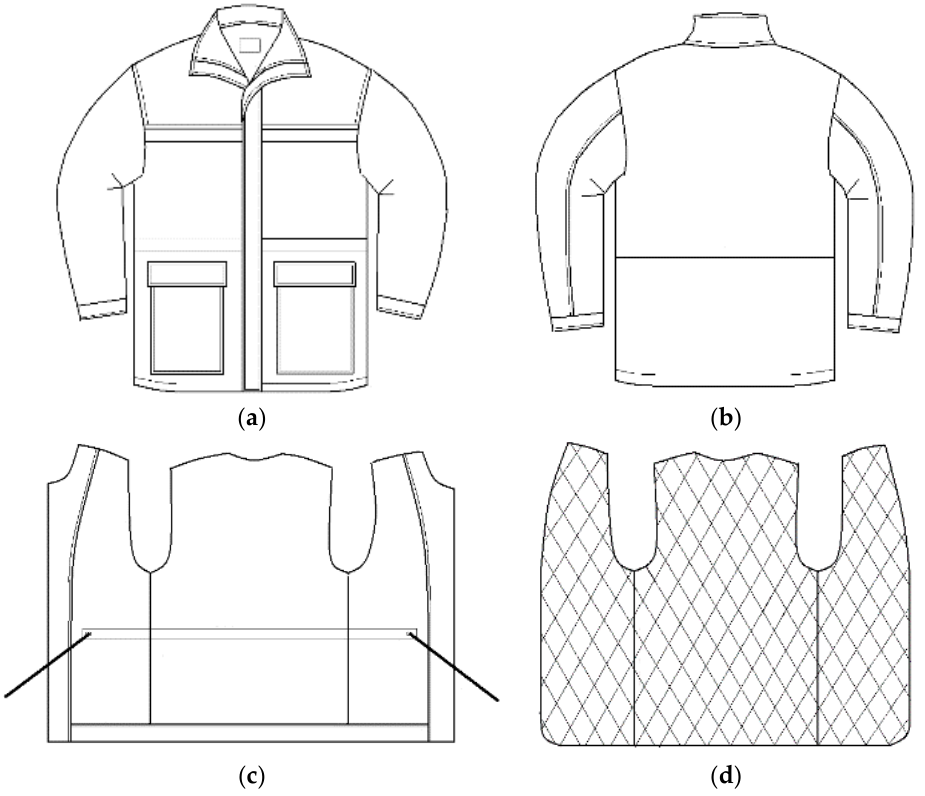
Figure 1. Basic construction features of the test garment. ( a ) The front of the outer shell; ( b ) the back of the outer shell; ( c ) lining; ( d ) detachable thermal insert.